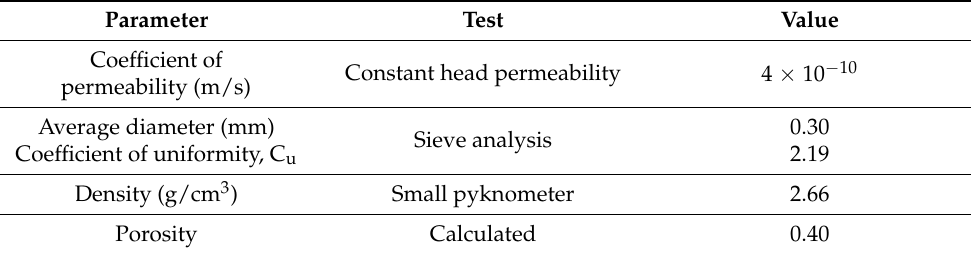
Table 1. The basic physical properties of